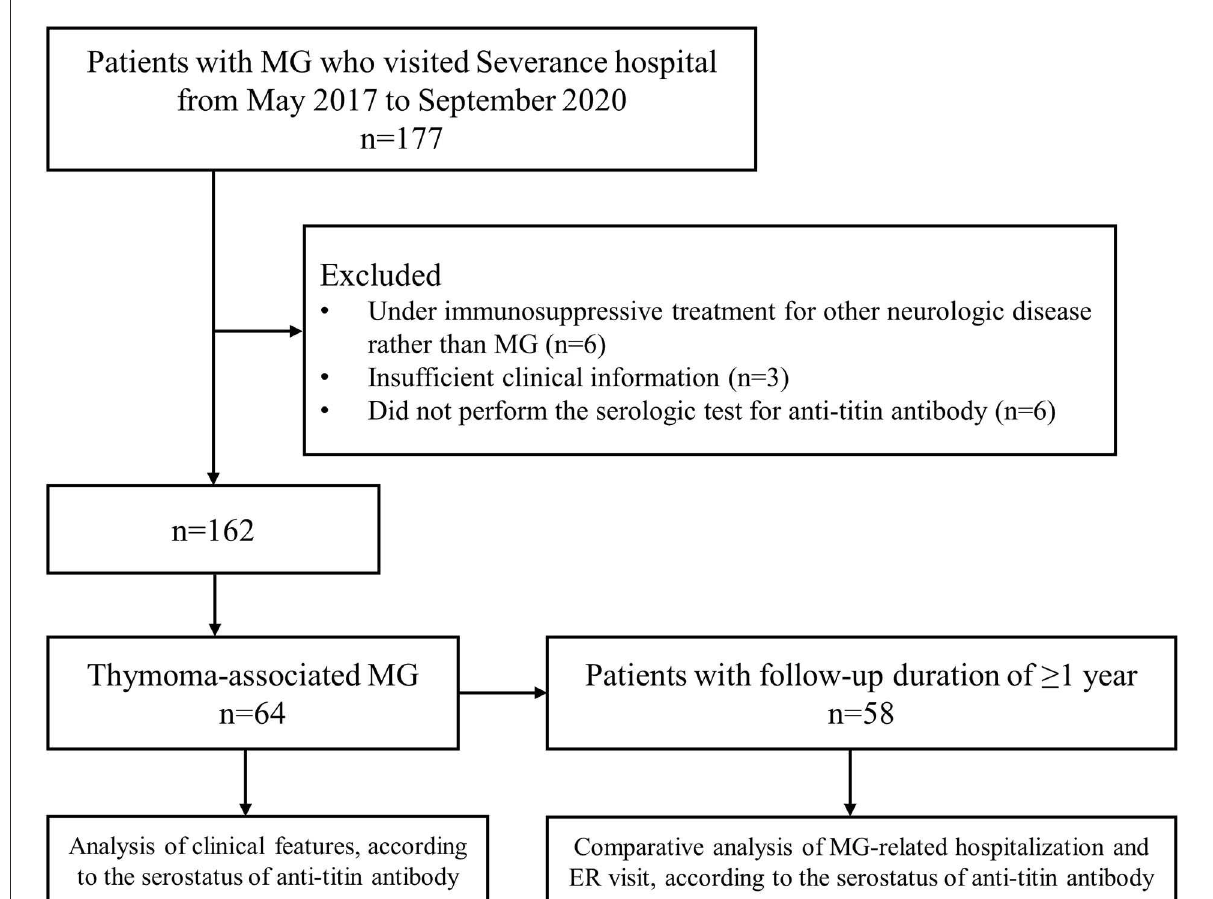
FIGURE1 A flow diagram of patients. During the study period, 177 patients with MG visited hospital, and 64 patients who fulfilled the inclusion criteria were selected. MG: myasthenia